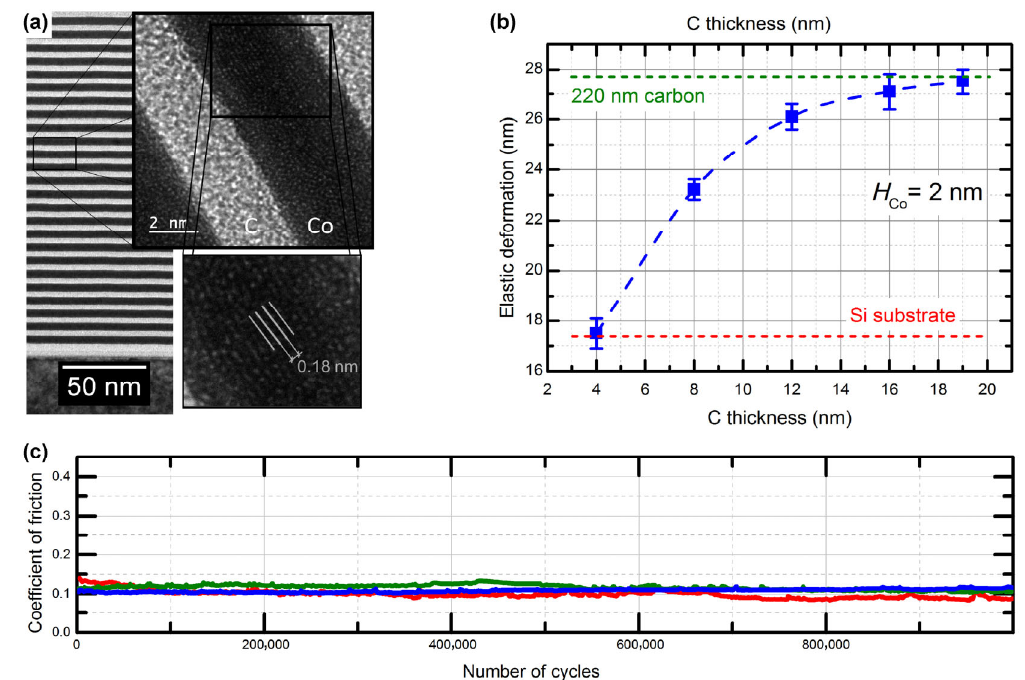
Fig. 7 (a) Cross-sectional TEM images cobalt/carbon multilayer coating. (b) Elastic deformation of the multilayer coatings as a function of the carbon thickness for a fixed cobalt thickness of 2 nm. (c) Friction coefficient as a function of the sliding distance for three repeated tests. Reprinted from Ref. [27], with permission from ACS